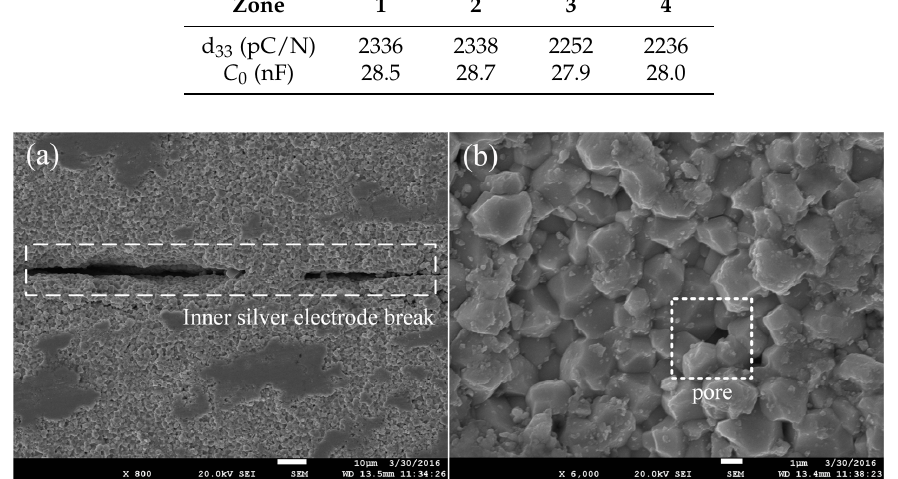
Figure 6. SEM photo of the cross ‐ section of the multilayer piezoelectric ceramic. ( a ) Cross ‐ section 800×; ( b ) Cross ‐ section 6000×.